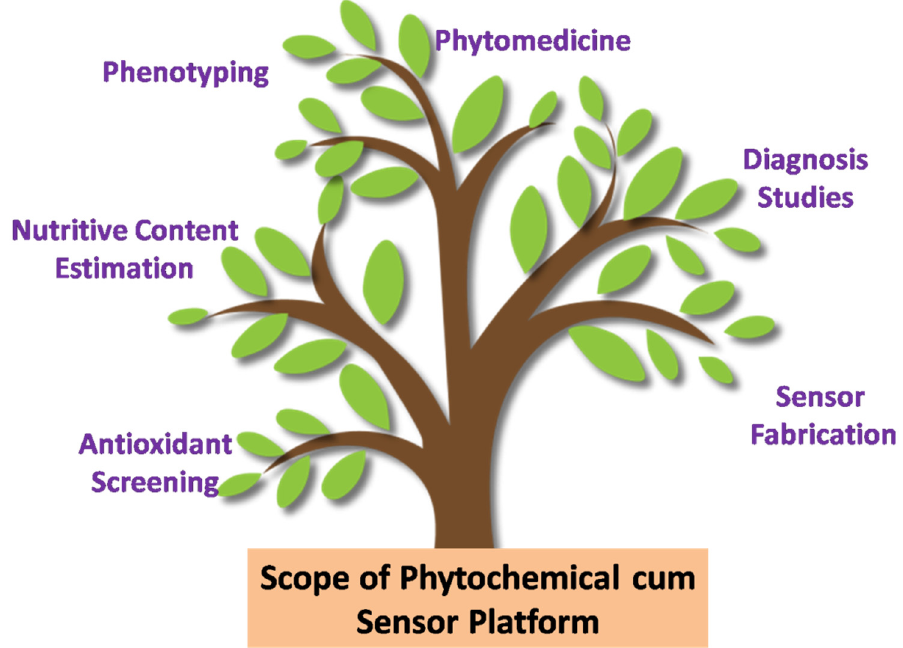
Figure 2. Diagrammatic illustration of various scopes that can be explored regarding phytochemical and/or sensor platforms.